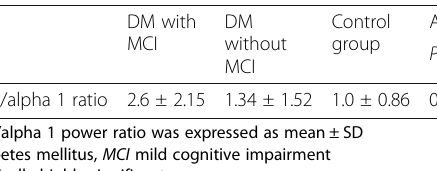
Table 4 The distribution of alpha 2/alpha 1 ratio among the study groups